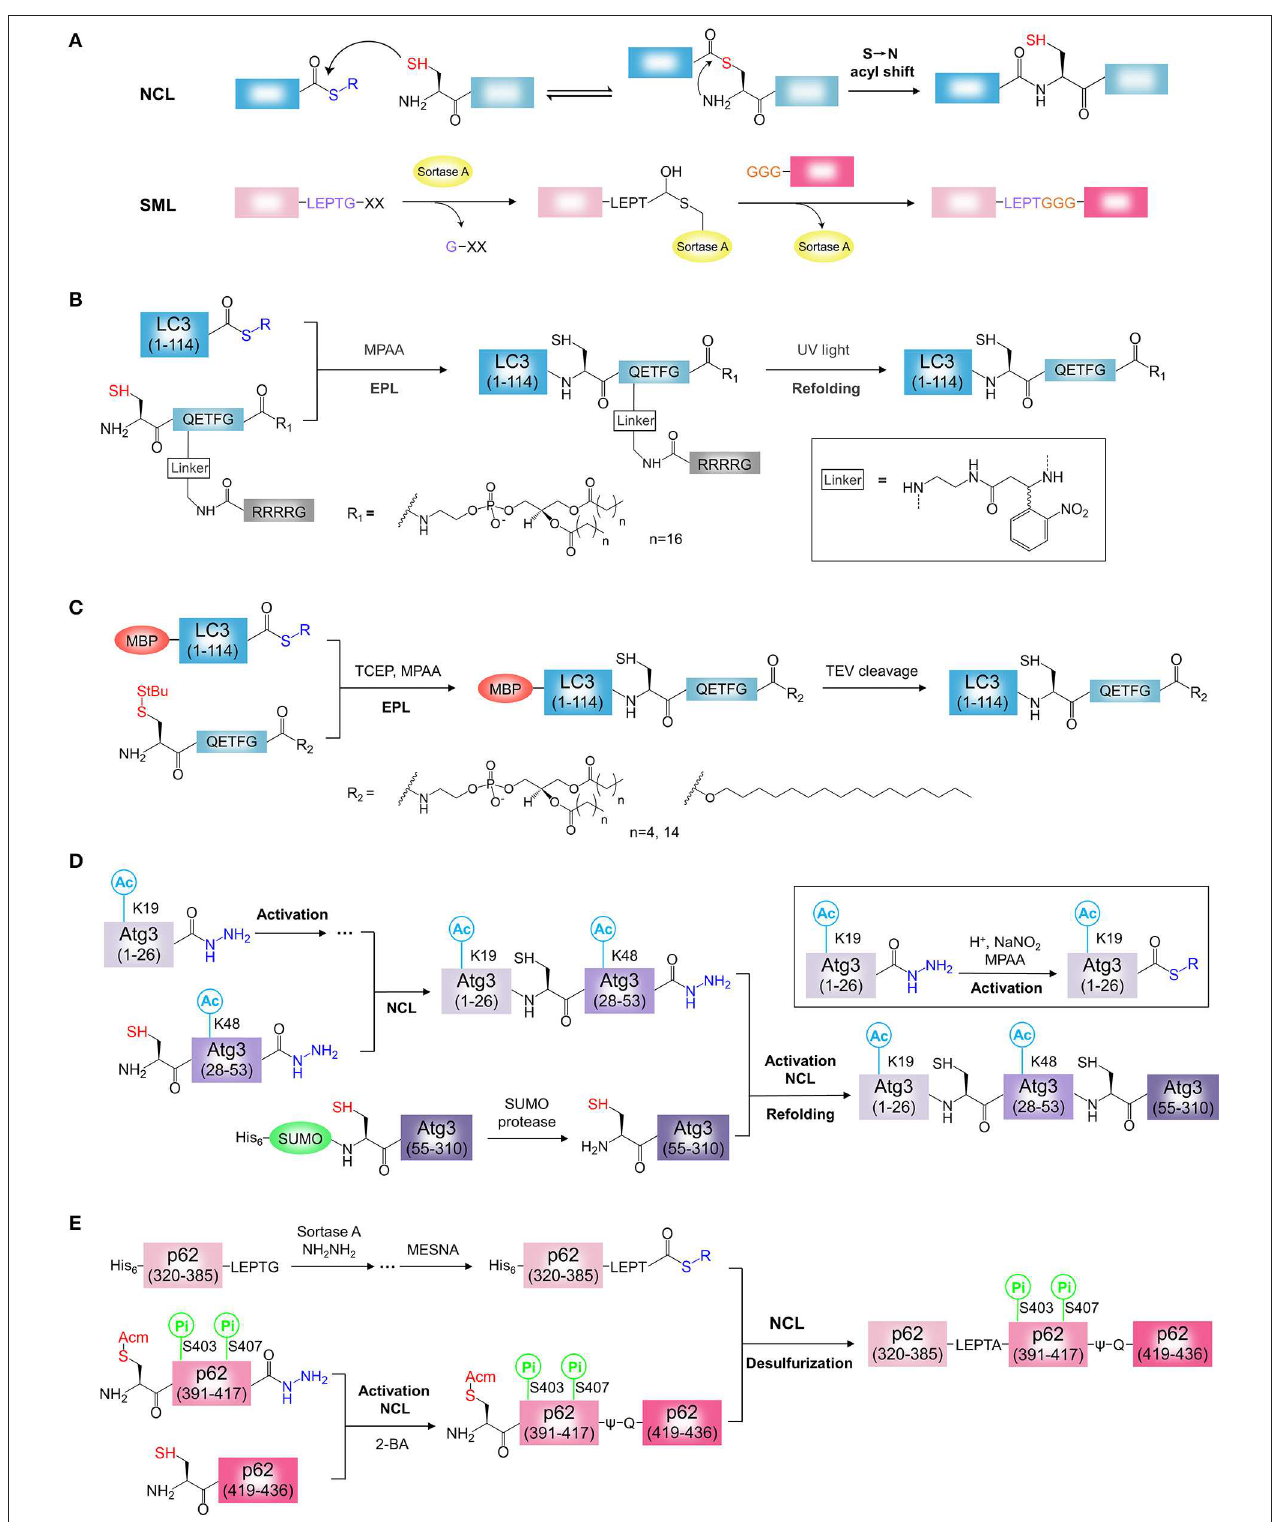
FIGURE 2 | Chemical synthesis of ATG proteins with PTM. (A) The mechanisms of NCL and SML. NCL, native chemical ligation; SML, Sortase A-mediated ligation. (B) Synthesis of LC3-PE using light activatable solubilizing side chain strategy. (C) Synthesis of LC3-lipid conjugates using MBP tag assisted solubilization strategy. (D) Synthesis of acetylated Atg3 by sequential hydrazide-based NCL. (E) Synthesis of phosphorylated p62 by SML and hydrazide-based NCL. 2-Bromoacetamide, 2-BA.